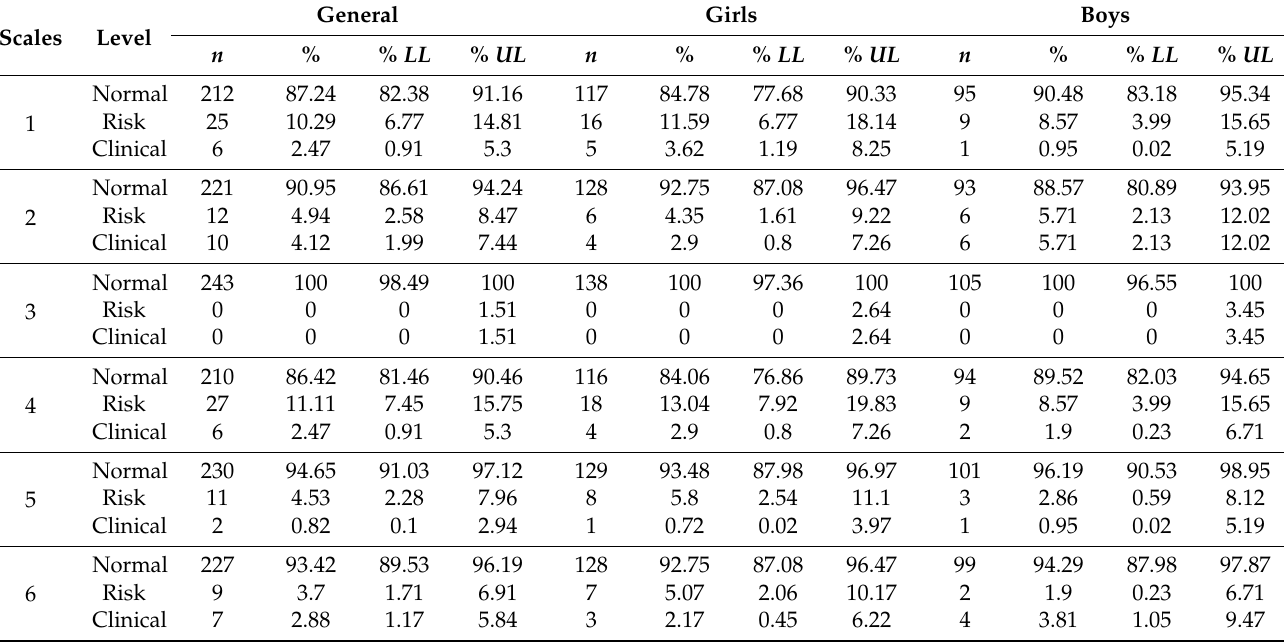
Table 6. Prevalence of DSM-oriented problems using the TRF.